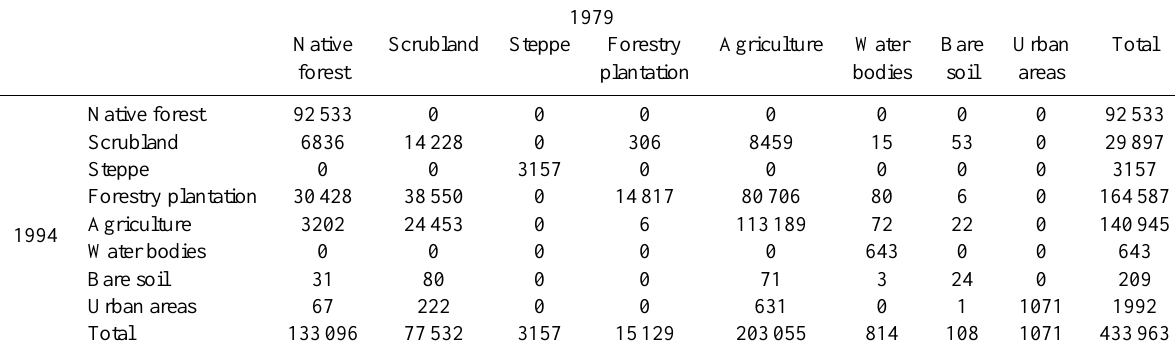
Table 3. Land use transition matrix for the years 1979 and 1994. Values in